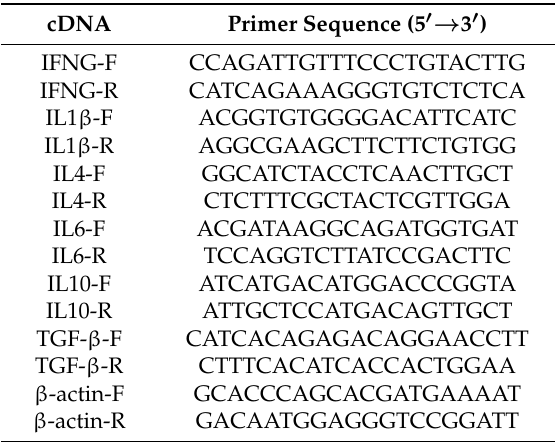
Table 5. Primer sequences for quantitative PCR.